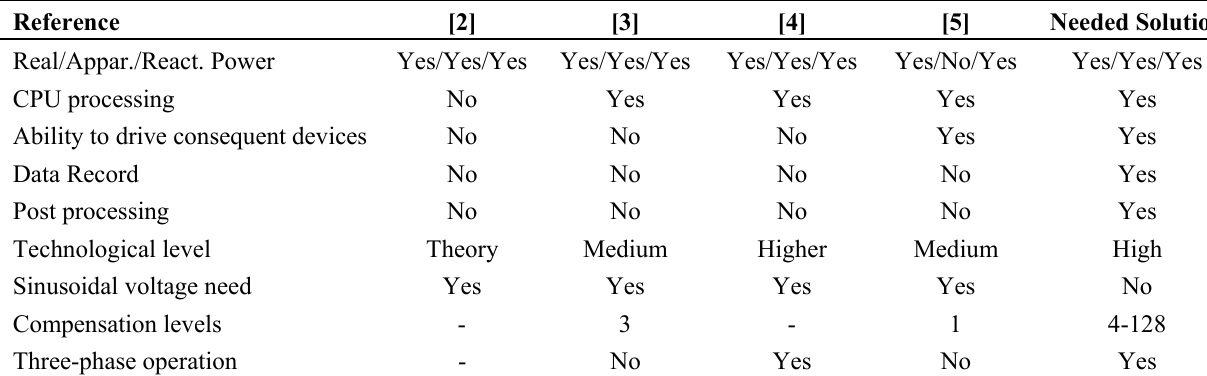
Table 1. Related work functions